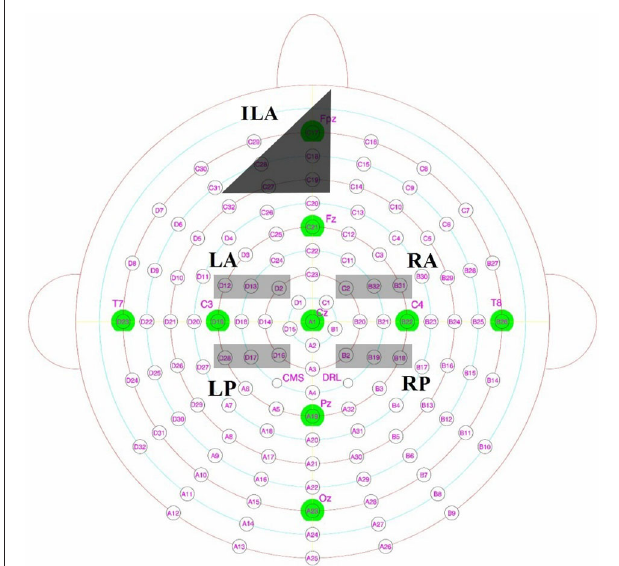
FIGURE 2 | Biosemi electrodes with key Jasper 10–20 locations overlaid, with left posterior (LP), left anterior (LA), right anterior (RA) and right posterior (RP) sites highlighted in light gray . Inferior mid left anterior (ILA) as described from the scalp maps is shown in dark